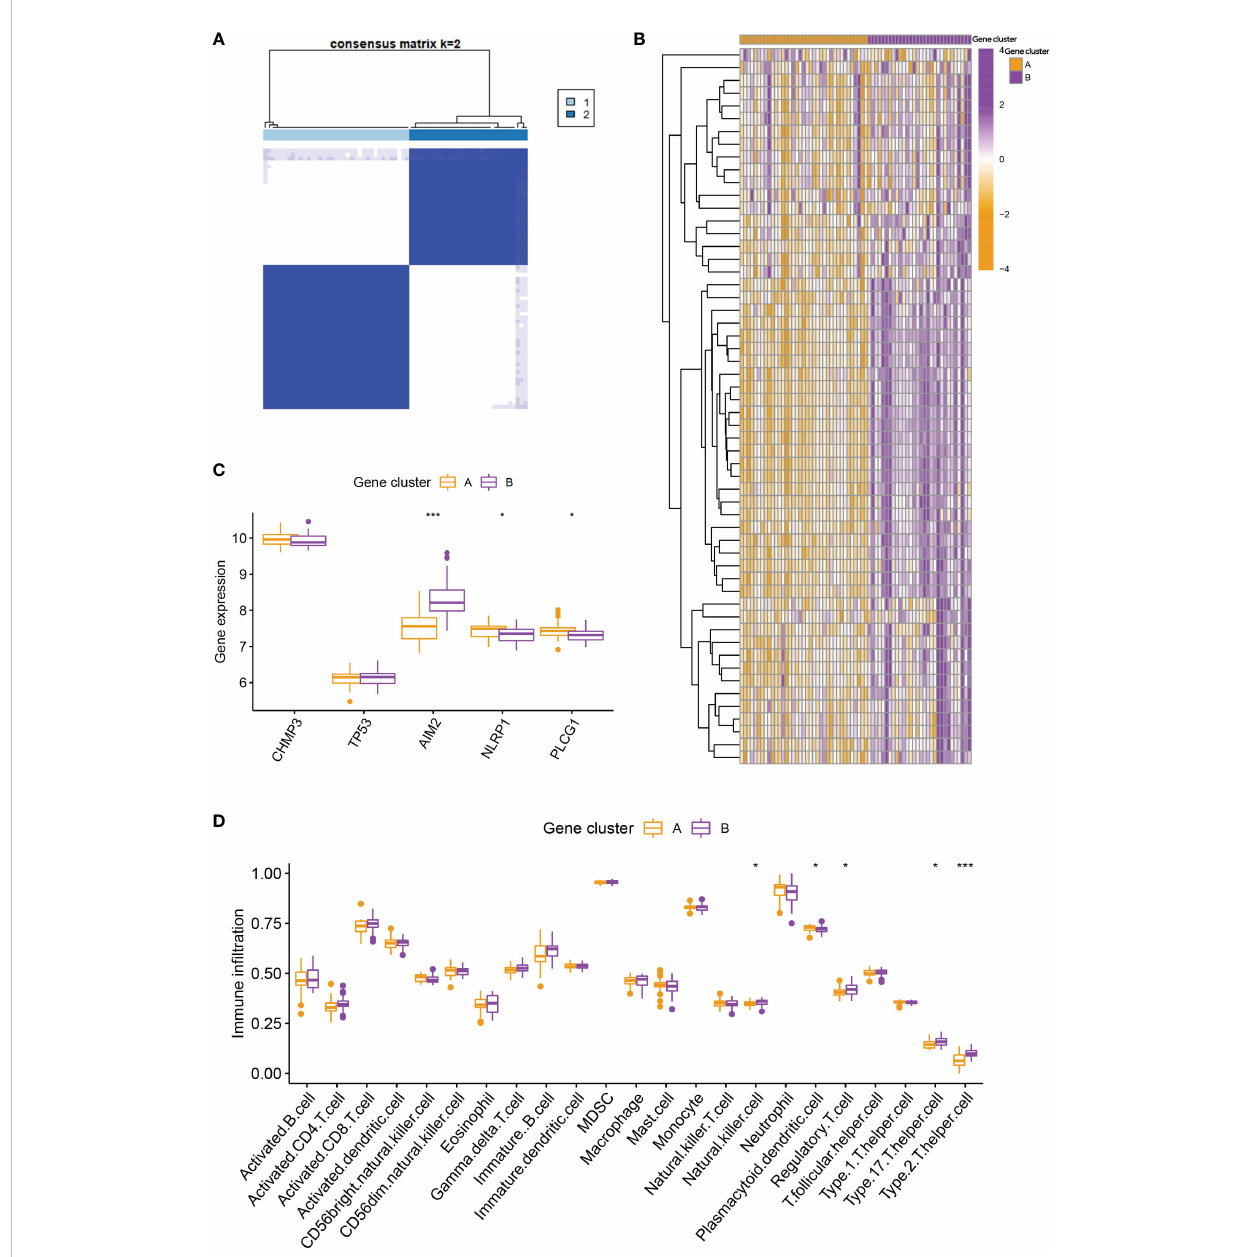
FIGURE 5 Consensus clustering of the DEGs. (A) Consensus matrices of the 56 DEGs for k = 2. (B) Expression heatmap of the 56 DEGs in gene cluster A and B. (C) Differential expression histogram of the 5 PRGs in gene cluster A and B. (D) Differential immune cell in fi ltration between gene cluster A and B. * means P < 0.05, *** means P <